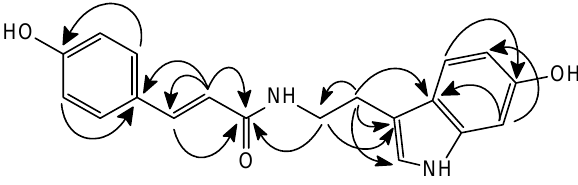
Figure 3. Significant correlations observed in HMBC of compound 2 .